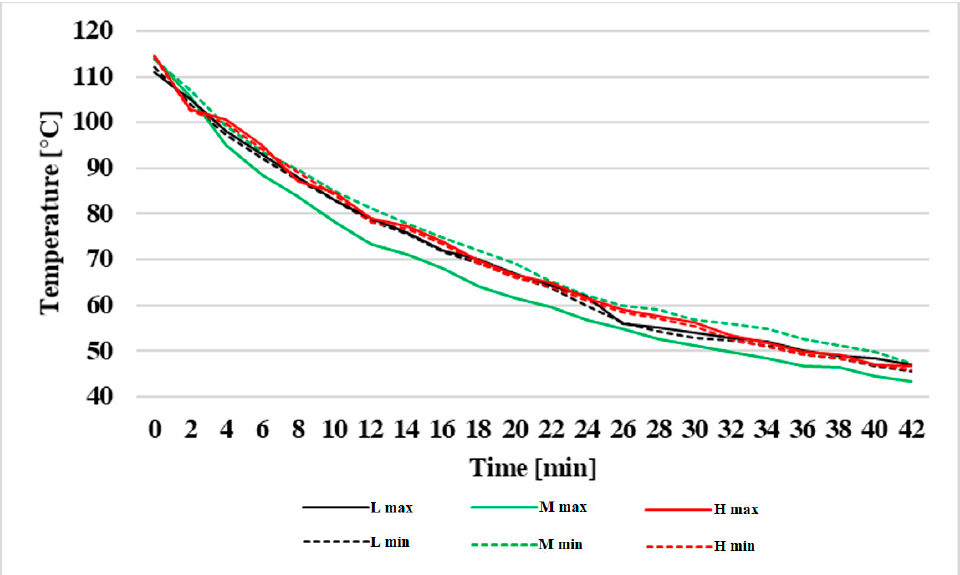
Figure 13. Brake discs’ temperature in the section of friction surface.